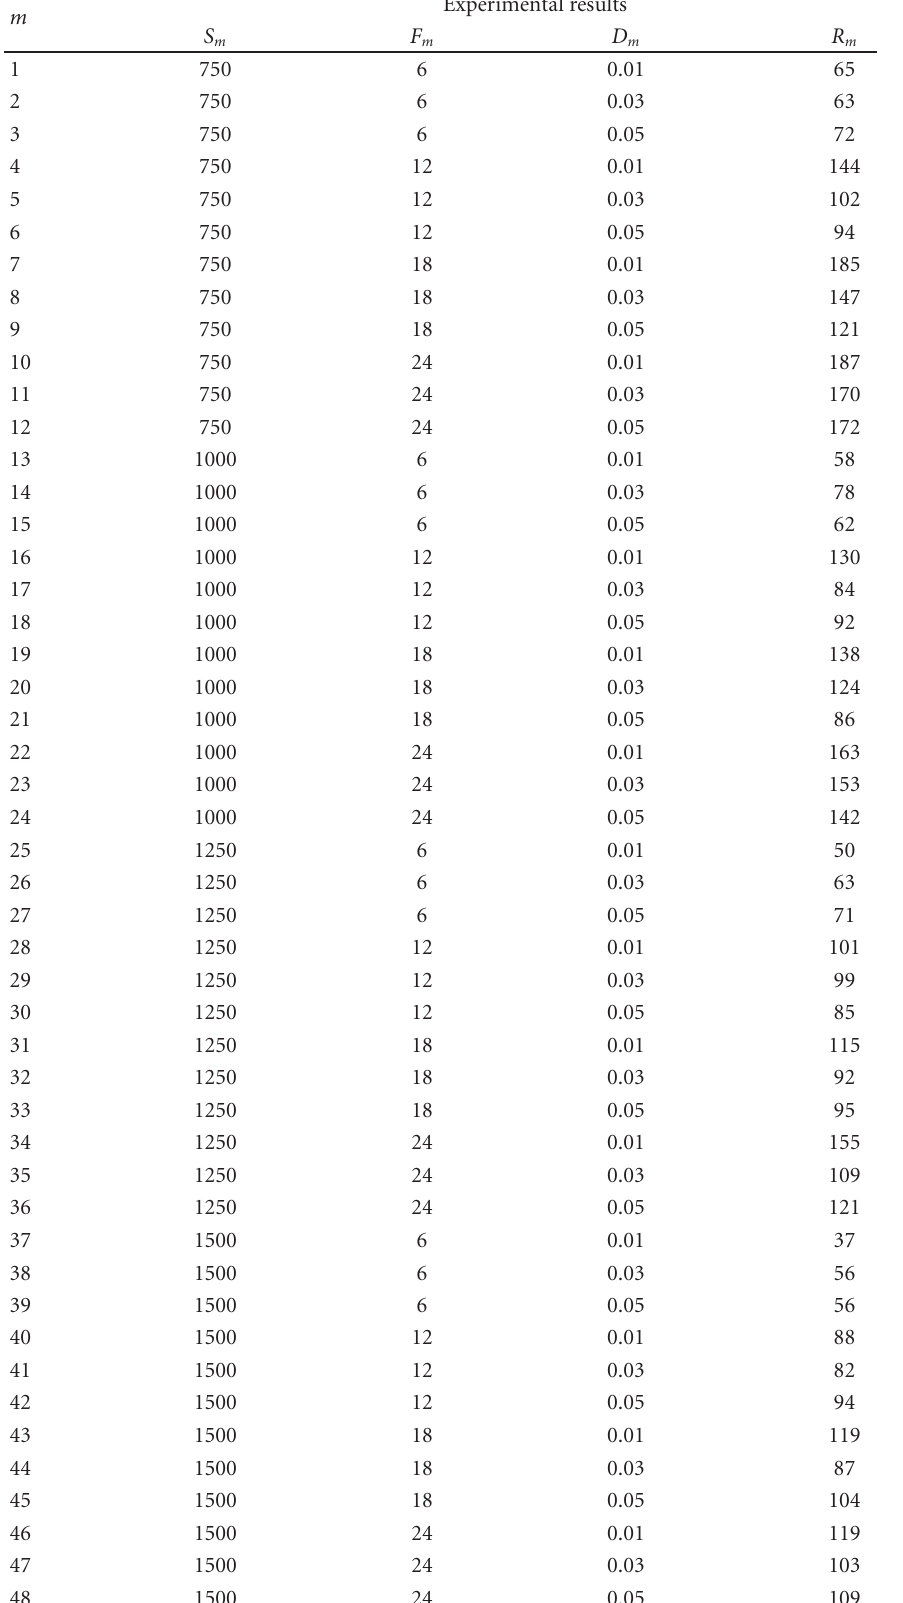
Table 3: Experimental results for training data (Lo [12] and Ho et al.